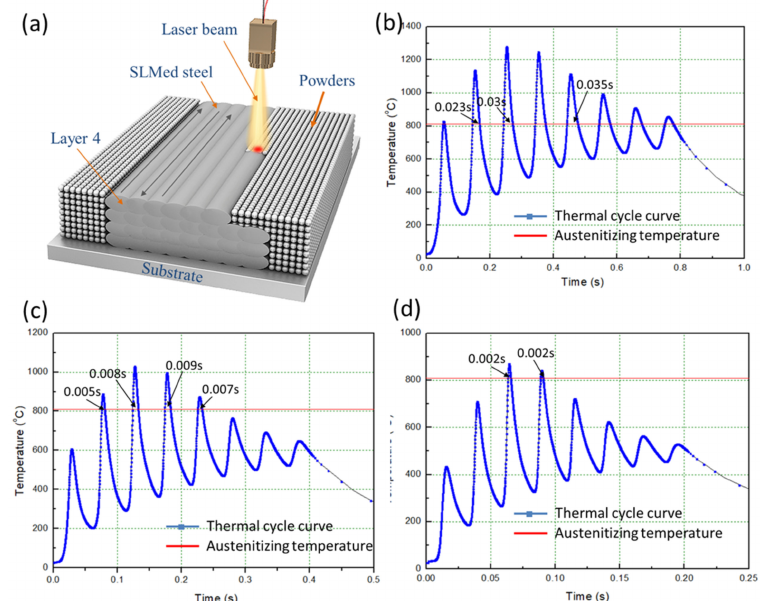
Figure 13. ( a ) Schematic diagram of SLM formation of low-alloy steel; ( b – d ) thermal cycle curves in the middle point of track three, layer three, at di ff erent EADs: ( b ) EAD = 142 J / mm 2 ; ( c ) EAD = 71 J / mm 2 ; ( d ) EAD = 47 J / mm 2